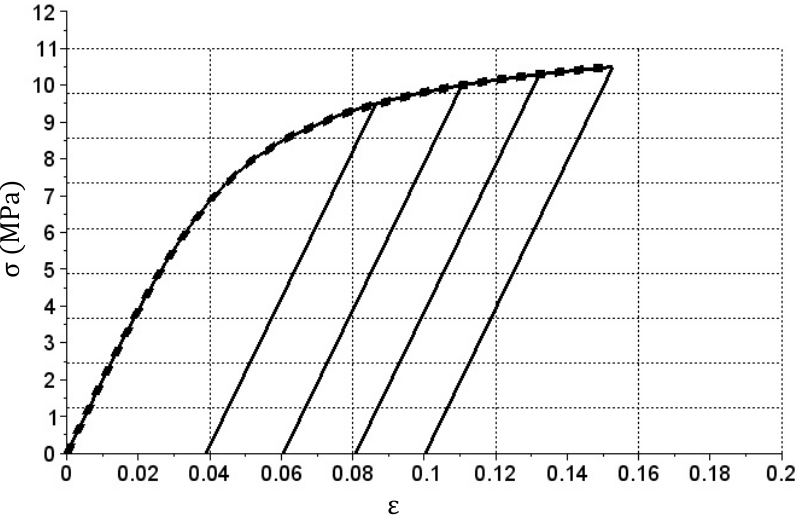
Figure 11. Comparison of the cyclic tension and relief graph (solid thin line) with a single cycle tension graph (dashed thick line).